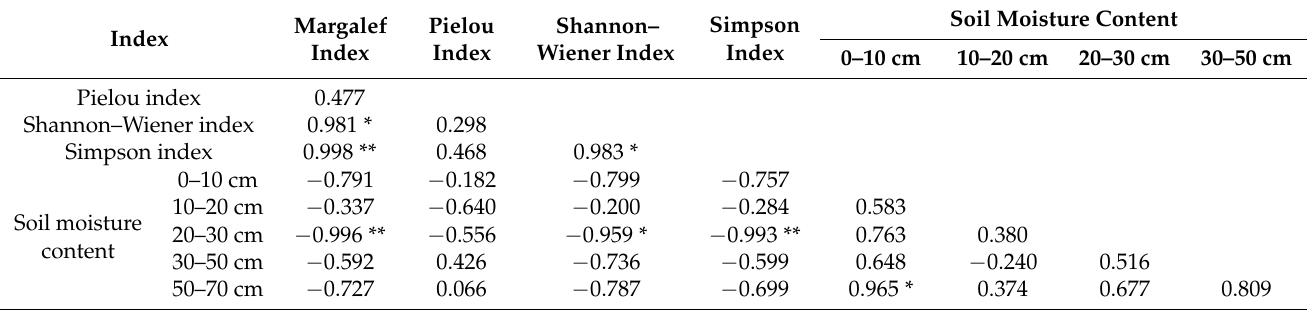
Table 4. Correlationcoefficientsbetweenspeciesdiversityindexandsoilmoisturecontentatdifferentdepths.